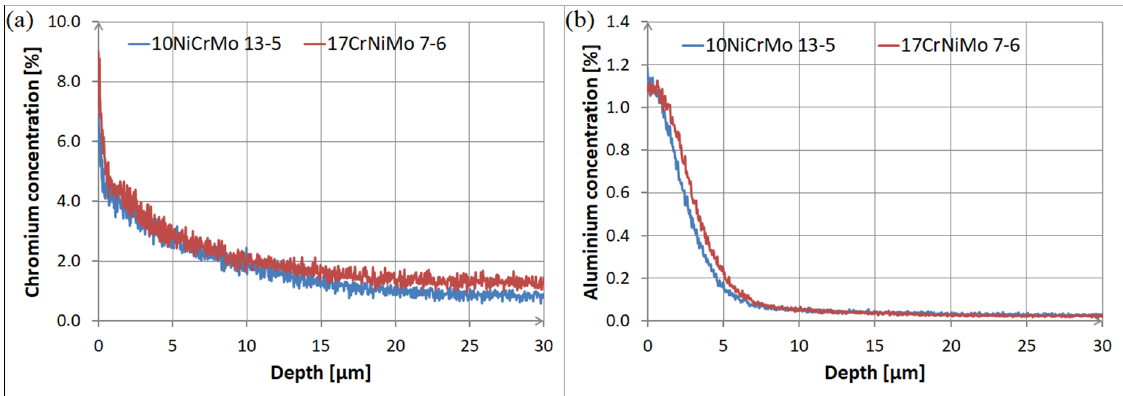
Figure 3. Quantitative profile of chromium and aluminum concentration for 10NiCrMo13-5 ( a ) and 17CrNiMo 7-6 ( b ) steels after low-pressure carburizing processes with ( a ) chromium plating; ( b ) aluminum coating.